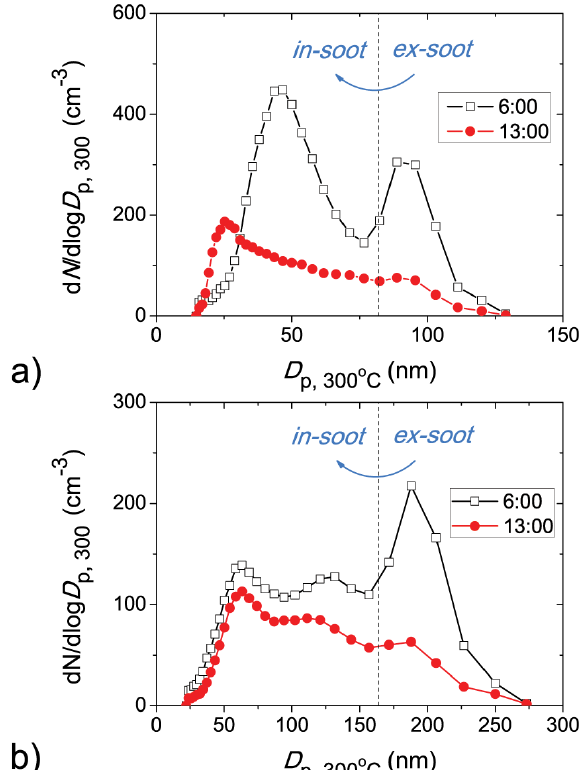
Fig. 10. Size distributions of nonvolatile residuals with initial diam- eter D p of (a) 100nm and (b) 200nm. D p , 300 ◦ C is the diameter of the nonvolatile residuals, i.e., particles after being heated at 300 ◦ C. The presence of particles with D p , 300 ◦ C >D p is due to the transfer function of the DMA used for initial particle